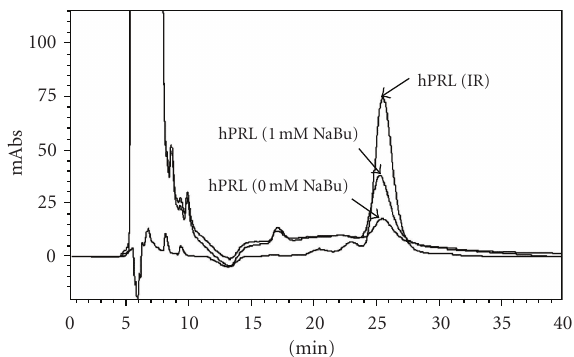
Figure 3: Overlay of RP-HPLC qualitative and quantitative analyses of hPRL secreted by CHO cells treated with di ff erent concentrations of NaBu. IR: Internal Reference Preparation of periplasmic E. coli- derived hPRL (7.0 μ g). mAbs: